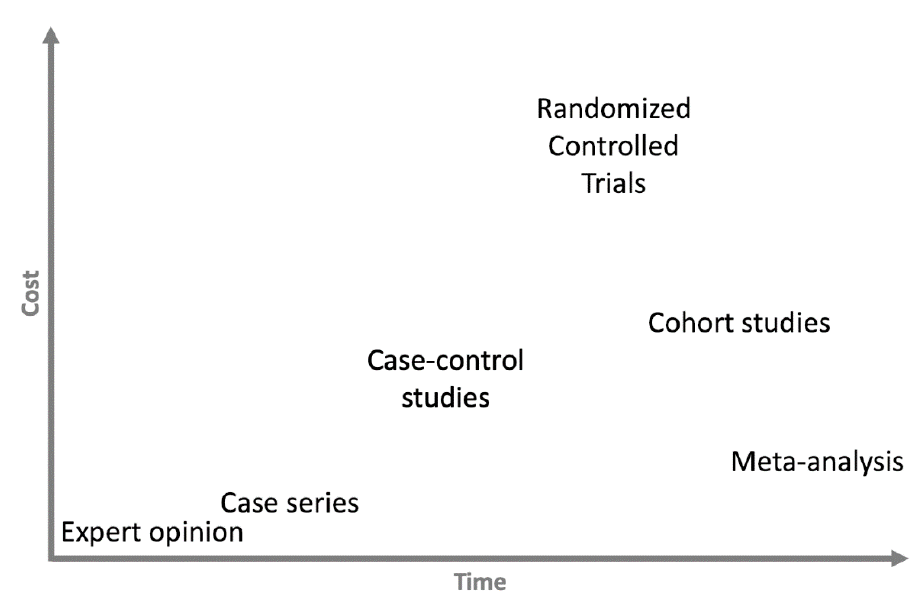
Figure 3. Relationship between time and cost of the different study